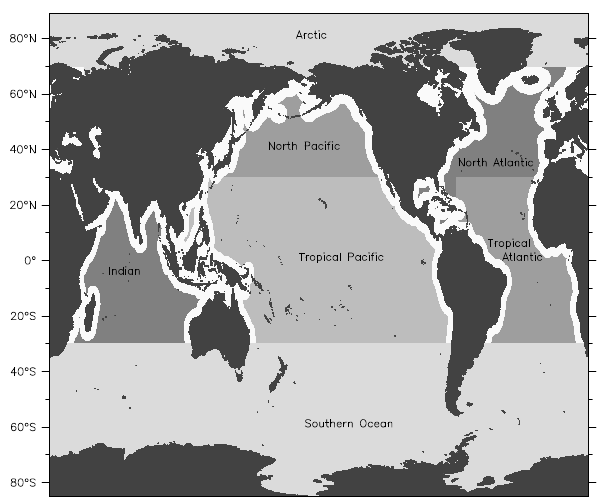
Figure 5. Quality control regions for SOCAT version 2 (Table 5). White shading corresponds to the coastal region. The regions have been defined for operational reasons and do not necessarily reflect common oceanographic